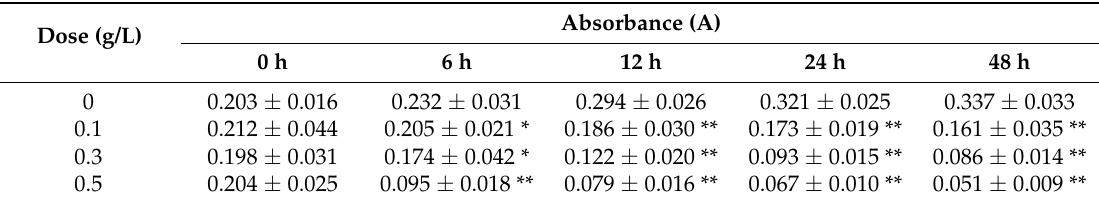
Table 1. Effect of ellagic acid microspheres on HepG2 cell proliferation.